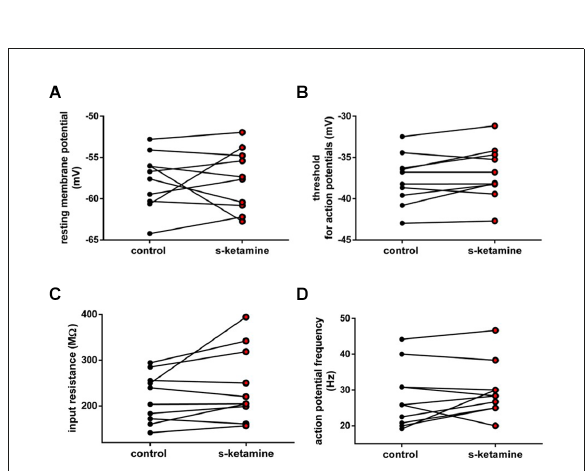
FIGURE5 (A) In the presence of s-ketamine no significant alteration of the resting membrane potential of thalamocortical relay neurons could be determined ( p = 0.770). (B) No significant difference of the threshold for generation of action potentials under s-ketamine was detected ( p = 0.074). (C) s-ketamine did not significantly change the neuronal input resistence, which was conducted by applying a hyperpolarizing current ( − 90 Pa; p =0.106). (D) Applicationofs-ketaminedidnotcausesignificant change of the tonic action potential frequency, conducted via injecting a depolarizing current of +180 pA to the cell ( p = 0.273).